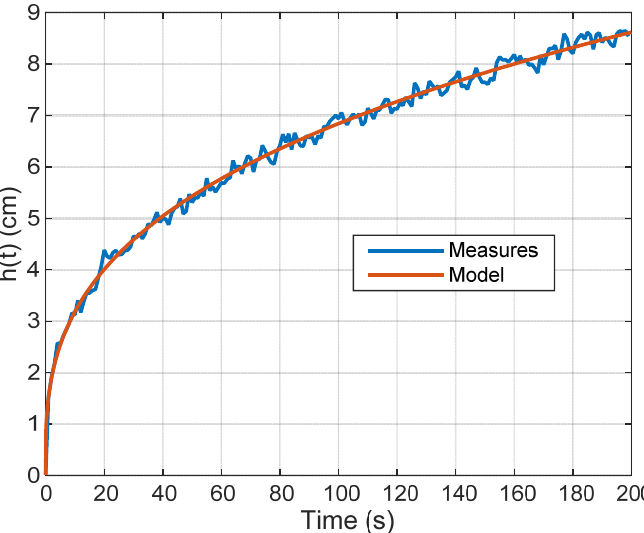
Figure 6. Comparison of the measures with the Model (35) response.